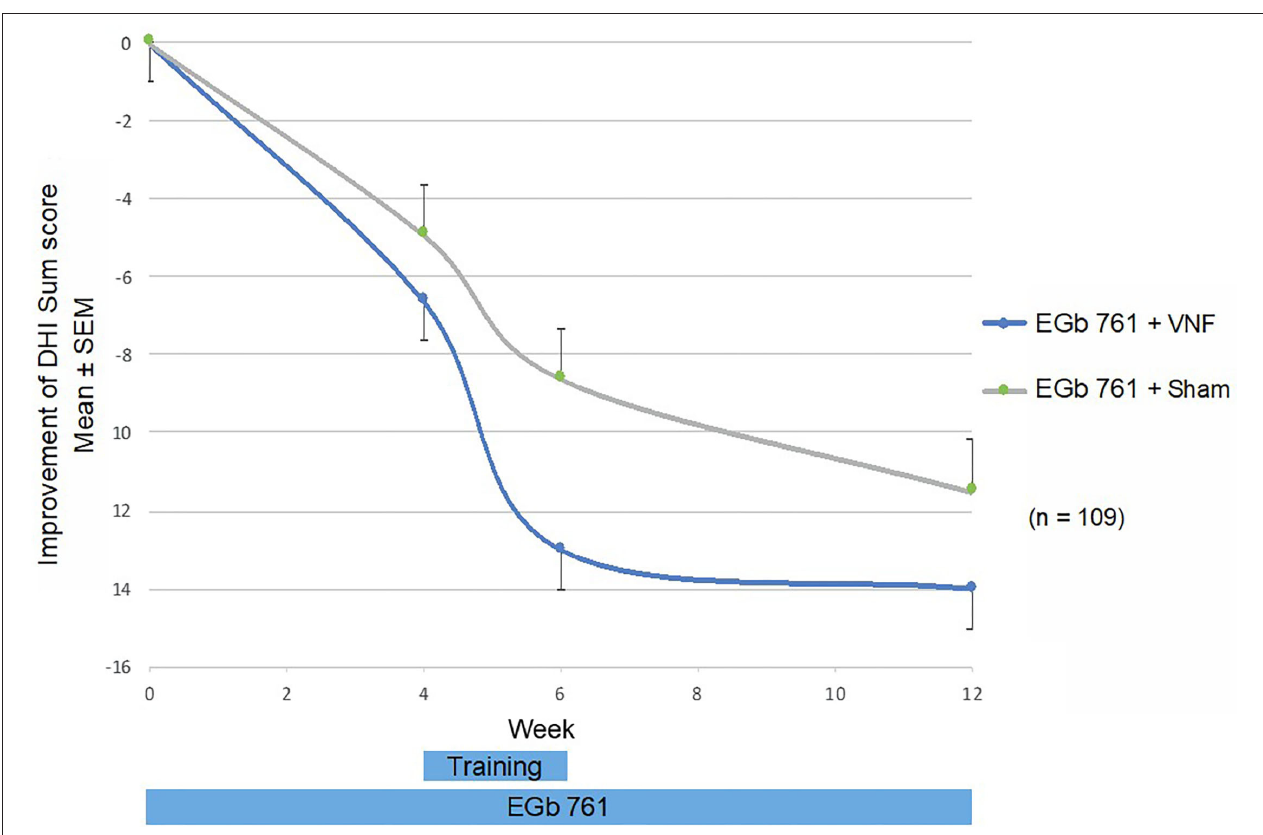
FIGURE 4 | DHI sum score: Change from baseline by visit and treatment